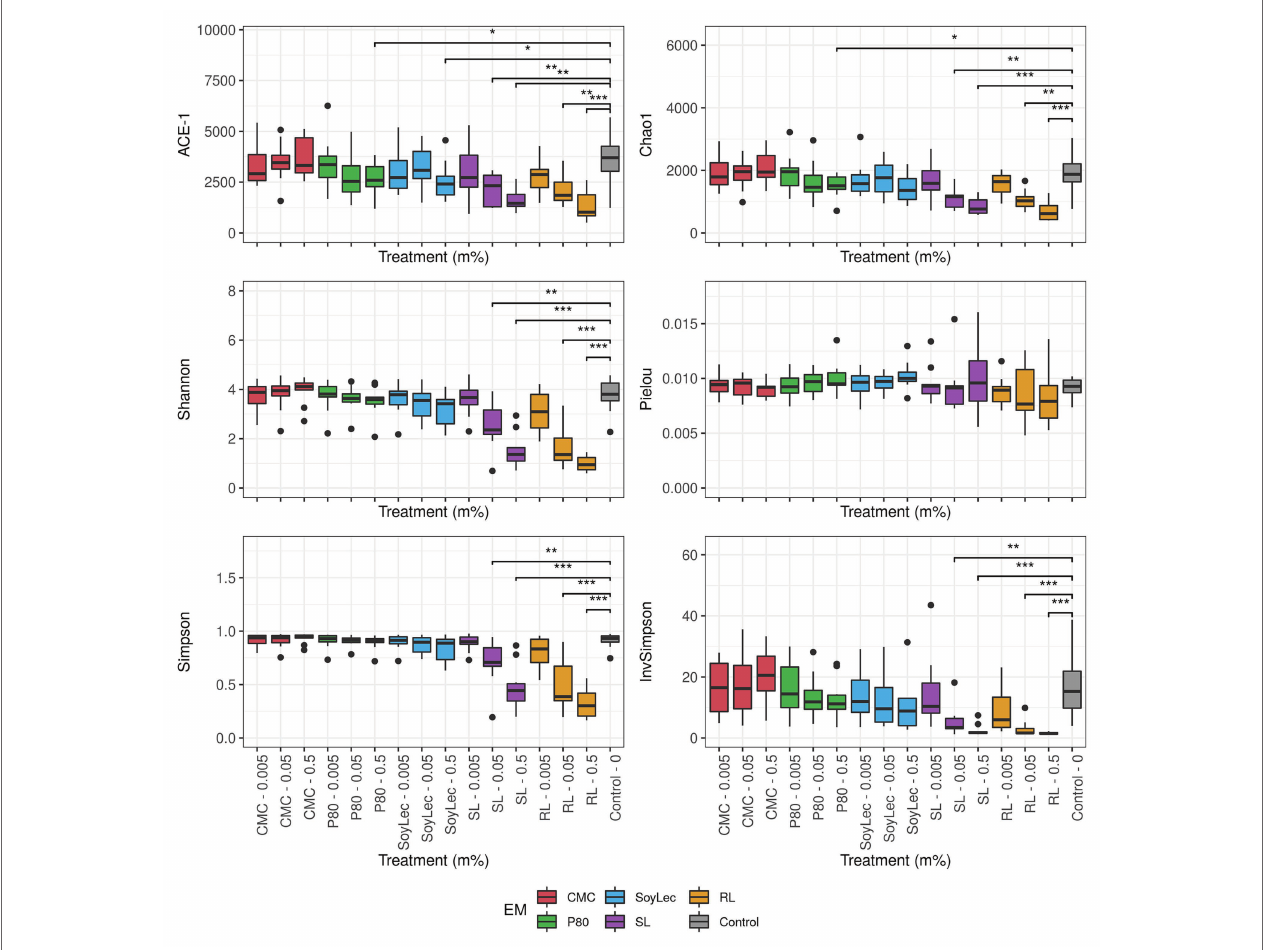
FIGURE 4 | Diversity parameters of gut microbial community obtained after 48 h of in vitro batch incubations of fecal material from 10 donors with sugar depleted medium supplemented with five emulsifiers at four concentrations. Samples were taken upon incubation (T0; 2–3 h after inoculation) as well as after 24 h (T1) and 48 h (T2) of incubation. Asterisks represent significant differences with control based on Wilcoxon Rank Sum tests with Holm’s correction ( α =